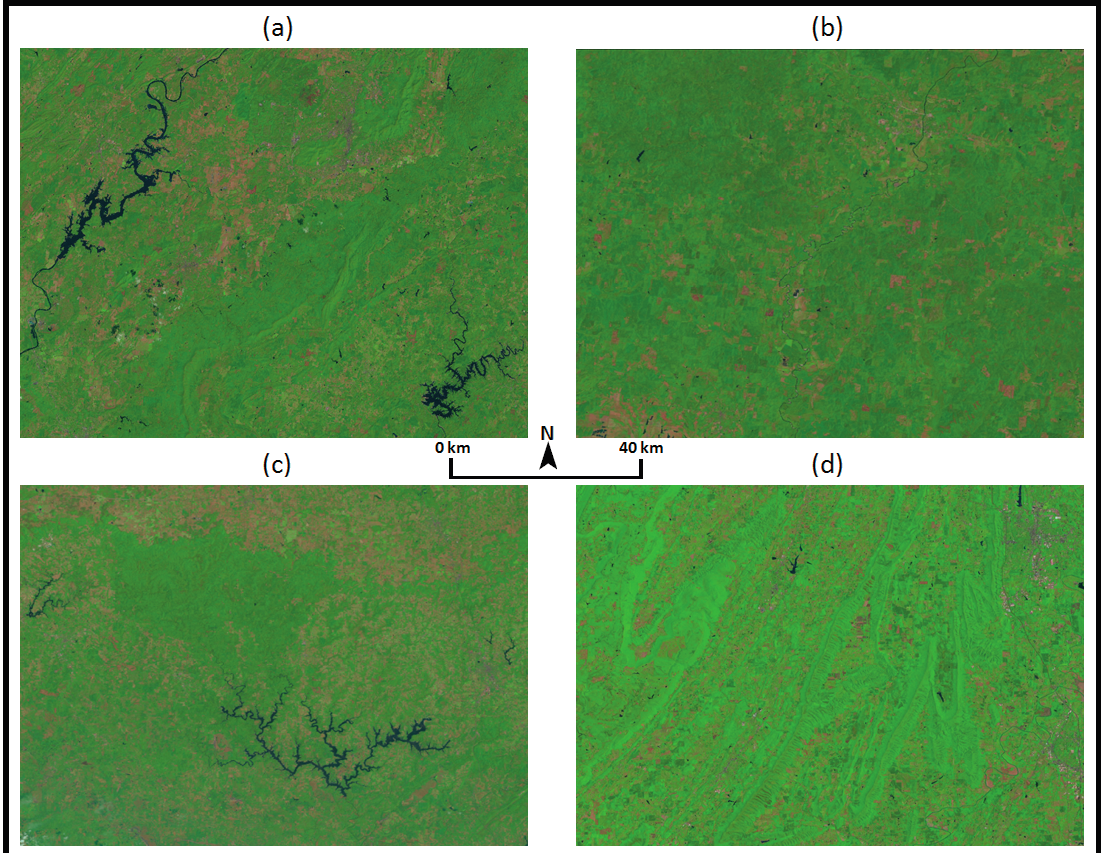
Figure 2. Pseudo natural color composite images using Landsat TM bands 5, 4, and 3 for (a) Talladega, (b) Oakmulgee, (c) Bankhead, and (d) Chatahoochee national